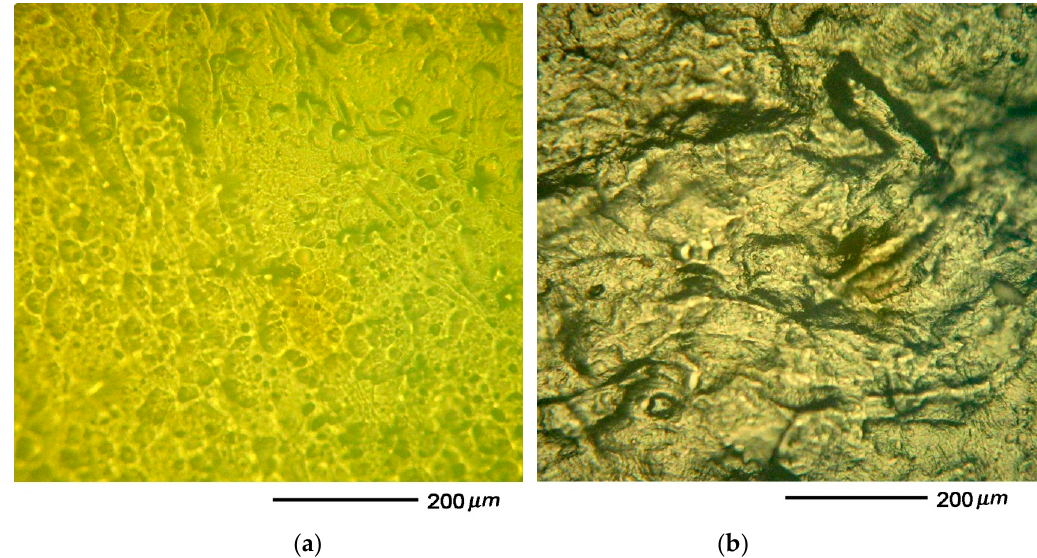
Figure 1. Optical images 200 × of human cartilage surfaces: ( a ) healthy and ( b ) a ff ected by osteoarthritis.